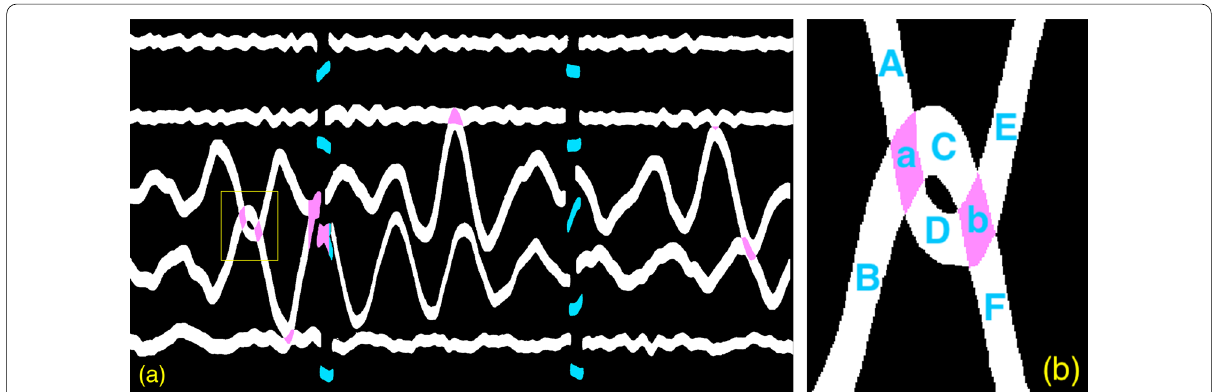
Fig. 11 Object crossing. a Screenshot of the classification window where trace objects are shown in white and time marks are in blue. Areas colored in magenta correspond to overlap pixels that have been automatically determined to belong to multiple objects. b Different objects that need to be connected within the area shown by yellow box in ( a ). The magenta regions a and b separate white regions to define independent objects A through F; in total, there are 8